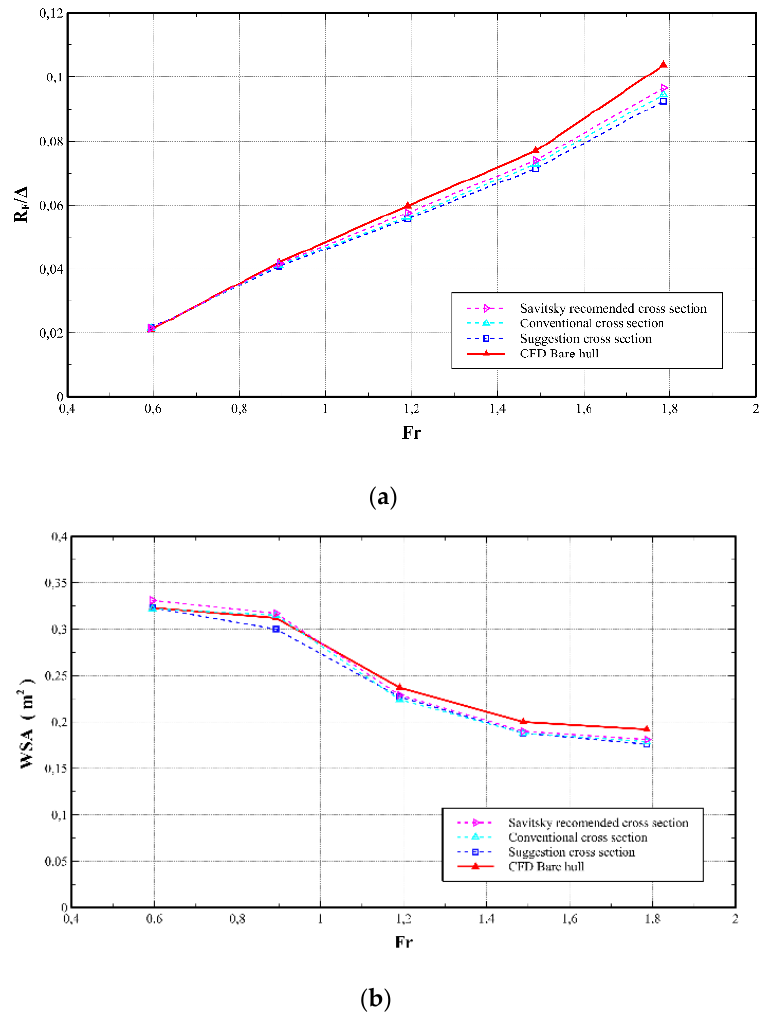
Figure 13. Relationship of resistance components ( a ) frictional resistance; ( b ) WSA for the variation of the cross-sectional shape.